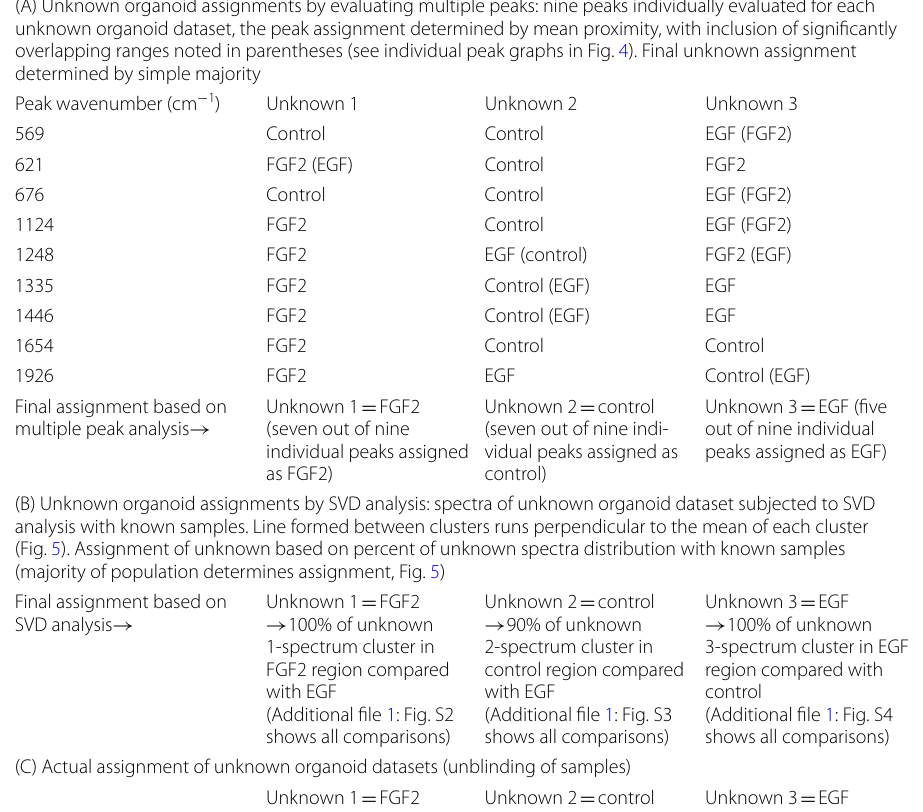
Table 2 Determination of unknown samples using two distinct approaches (A) Unknown organoid assignments by evaluating multiple peaks: nine peaks individually evaluated for each unknown organoid dataset, the peak assignment determined by mean proximity, with inclusion of significantly overlapping ranges noted in parentheses (see individual peak graphs in Fig. 4). Final unknown assignment determined by simple majority Peak wavenumber (cm − 1 )